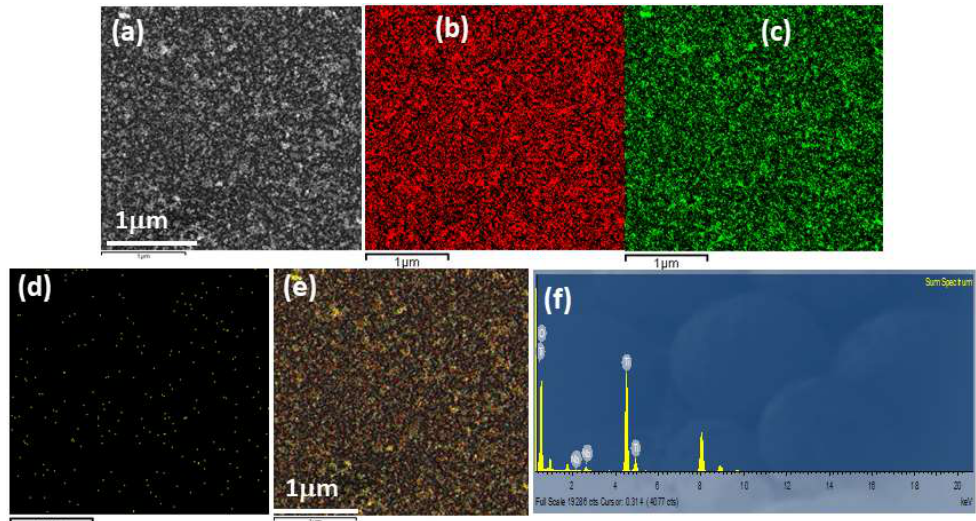
Figure 8. ( a , b ) TEM images, ( c ) HRTEM image, and ( d ) SAED pattern of the 5 nm Nb/TiO 2 nanopar- ticles, ( e ) elemental mapping of Ti, O, and Nb and ( f ) EDX analysis of 5 nm TiO 2 nanocomposites. The atomic percentage for O, Ti, and Nb is 73.97, 25.94, and 0.09,